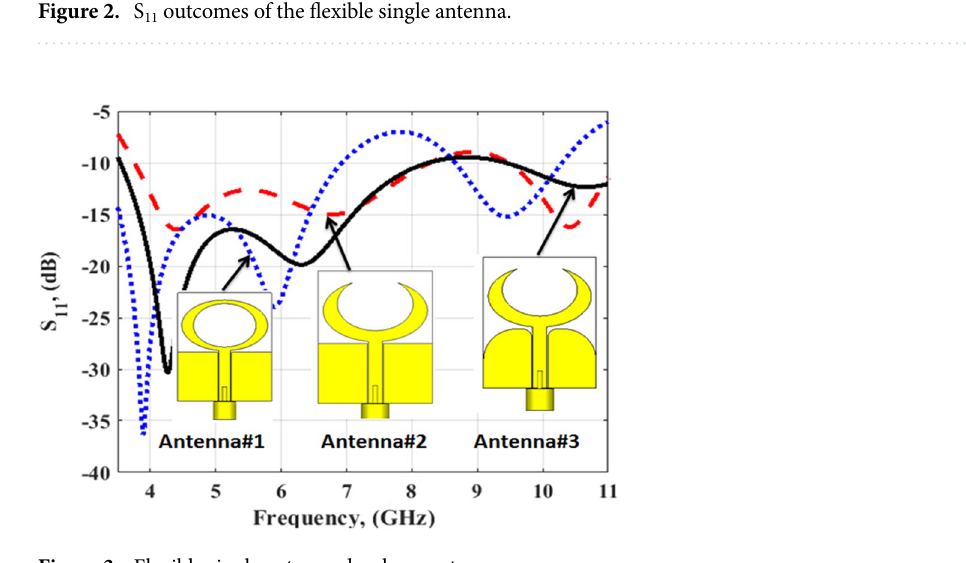
Figure 3. Flexible single antenna